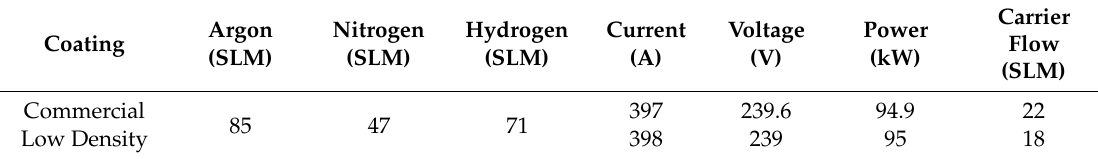
Table 2. Summary of plasma spray